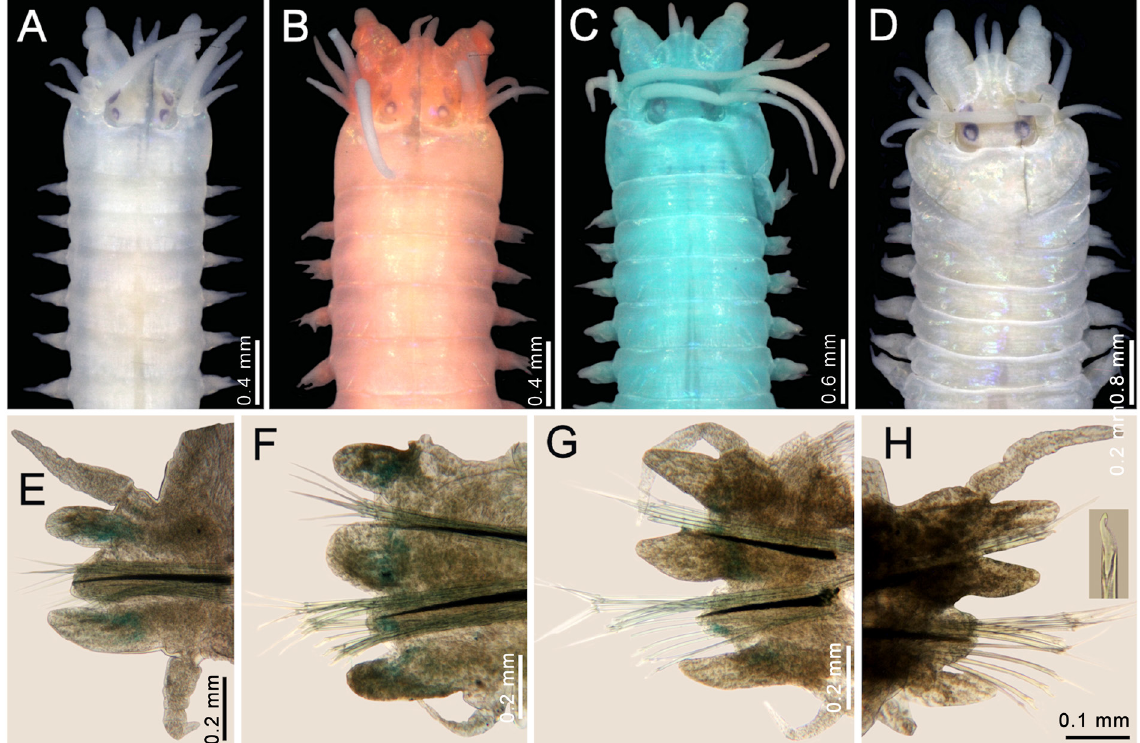
Fig. 16. Nereis lucipeta Ehlers, 1908, reinstated, non-type specimens (MNHN 83-52), anterior region in dorsal view. A . 0.9 mm wide. B . 1.2 mm wide, after Shirlastain-A staining. C . 1.4 mm wide, after methyl green. D . 2.0 mm wide. E . Largest fragment, chaetiger 2, right parapodium, anterior view. F . Same, chaetiger 15, right parapodium, anterior view. G . Same, chaetiger 28, right parapodium. H . Complete specimen, chaetiger 65, left parapodium, anterior view (inset: homogomph